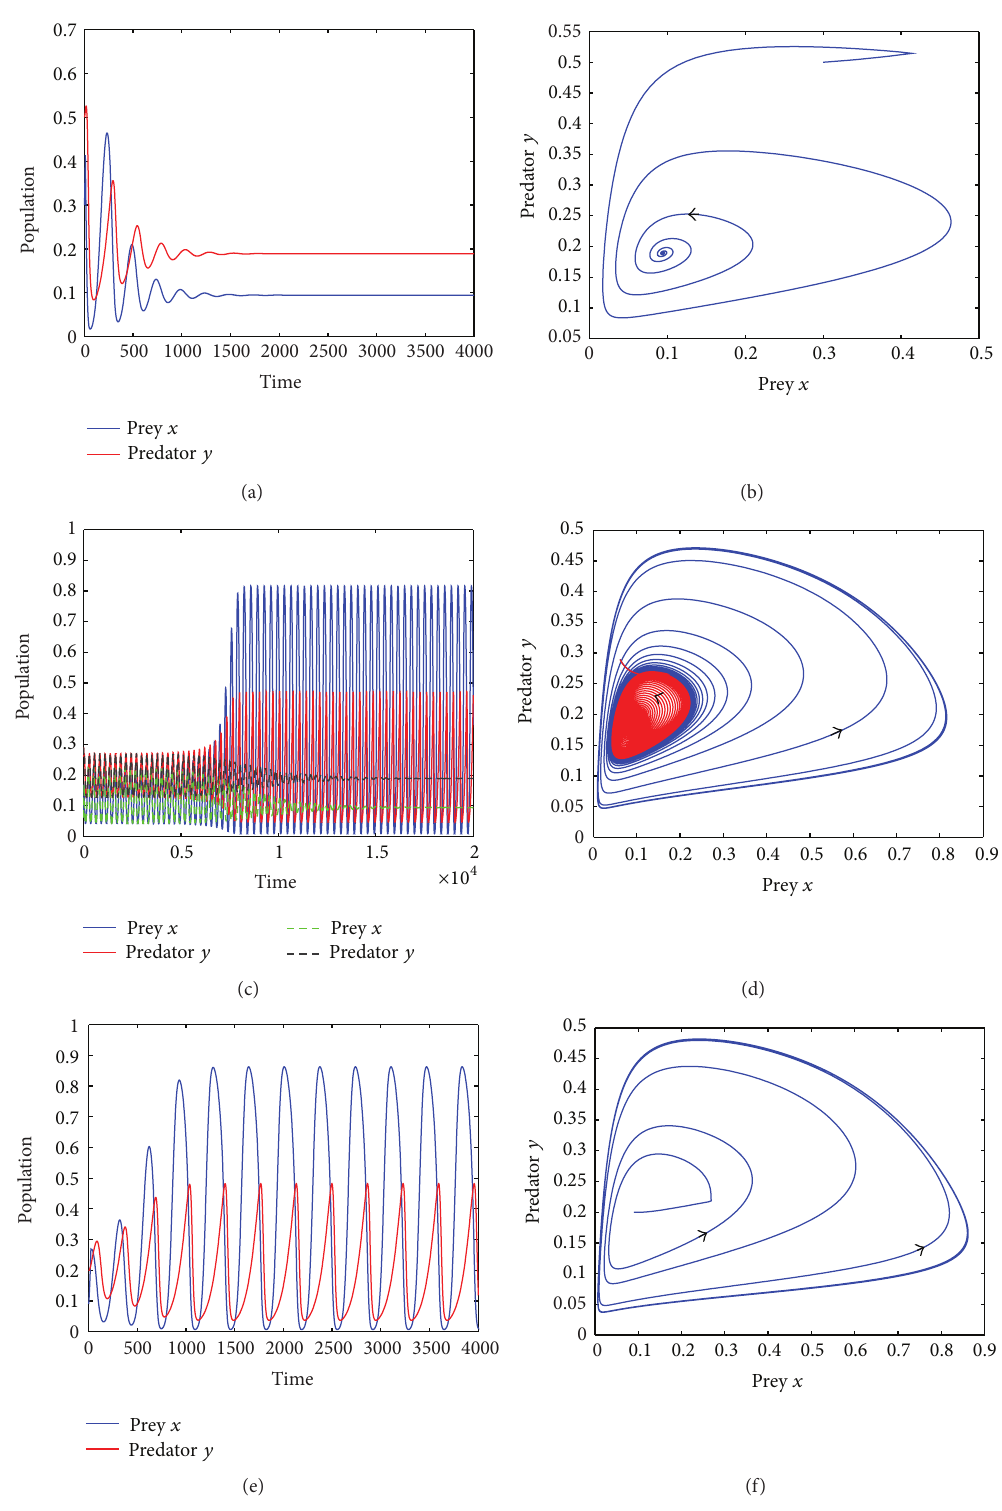
Figure 4: The trajectory graphs and phase portrait of system (6) for (𝛼,𝛽) ∈ 𝐷 11 with 𝛼 = 0.2 , 𝛽 = 2 , and 𝛾 = 0.2 . (a)-(b) When 0 ≤ 𝜏 < 𝜏 0 , the equilibrium 𝐸 ∗ is stable. (c)-(d) Simulations of subcritical Hopf bifurcation. Starting from the initial value (𝑥(0),𝑦(0)) = (0.0615, 0.2897) , the trajectory slowly gets away from a small-amplitude unstable periodic solution and finally converges to a large-amplitude stable periodic solution. Starting from the initial value (𝑥(0),𝑦(0)) = (0.0615, 0.2895) , the trajectory converges to 𝐸 ∗ . (e)-(f) When 𝜏 > 𝜏 0 , the equilibrium 𝐸 ∗ is unstable with a large-amplitude stable periodic